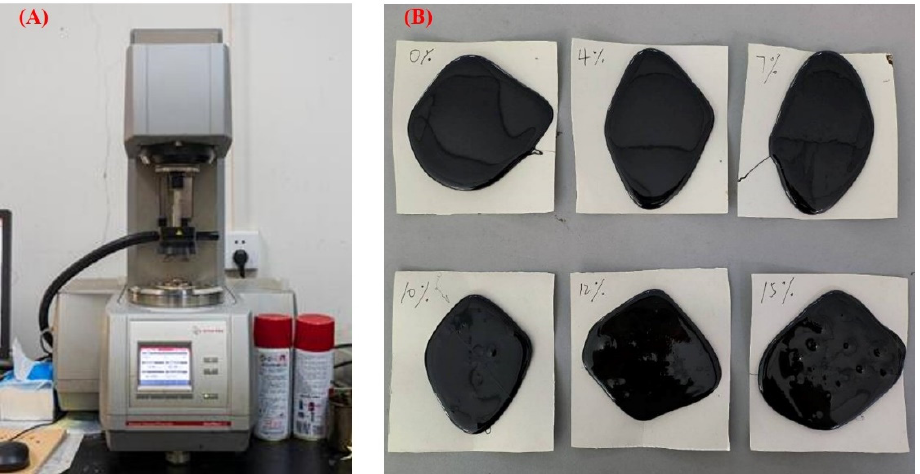
Figure 7. ( A ) DSR instrument; ( B ) modified asphalt specimens with different dosage.